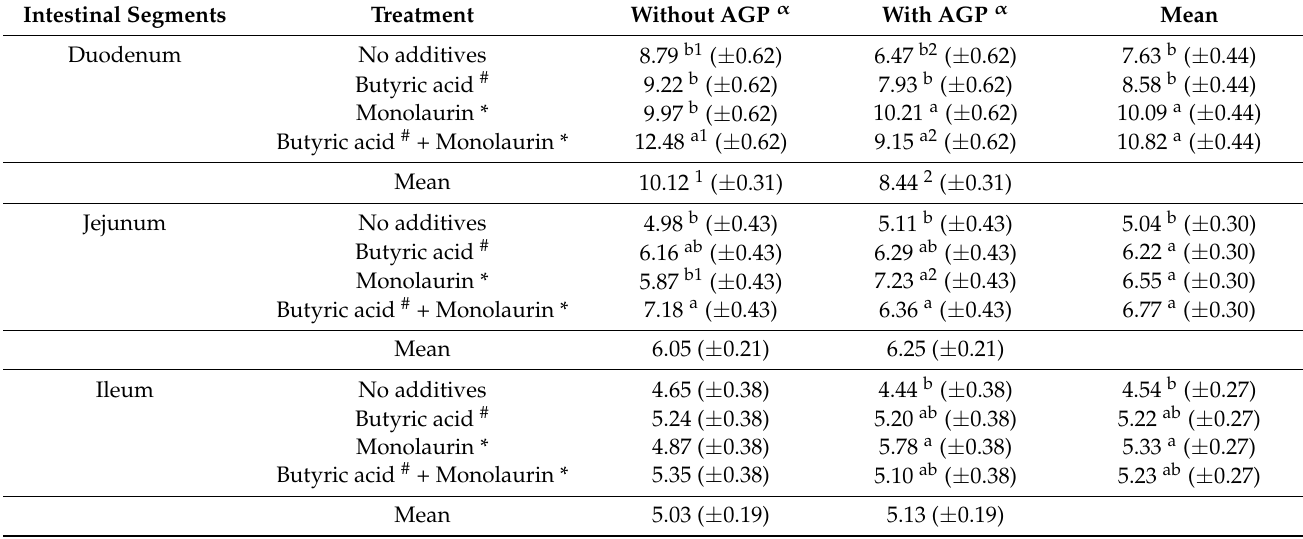
Table 9. The effect of butyric acid and α -monolaurin, with and without the inclusion of antibiotic growth promoters, on VH:CD ratio of the duodenum, jejunum and ileum of broilers at 33 days of age ( ± standard error of the mean). Intestinal